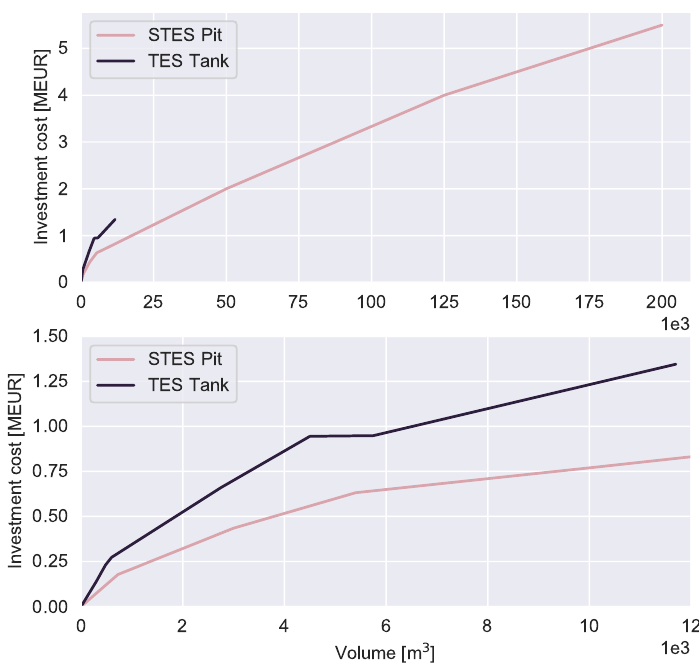
Figure A2. Cost evolution in function of volume for TES tanks and TES pits, using a linear interpolation between known investment costs for real systems. Data derived from Schmidt and Miedaner [53]. Note that the lower graph is representing the same data as the upper plot, but focussing on the lower volume range of the TES tank data.